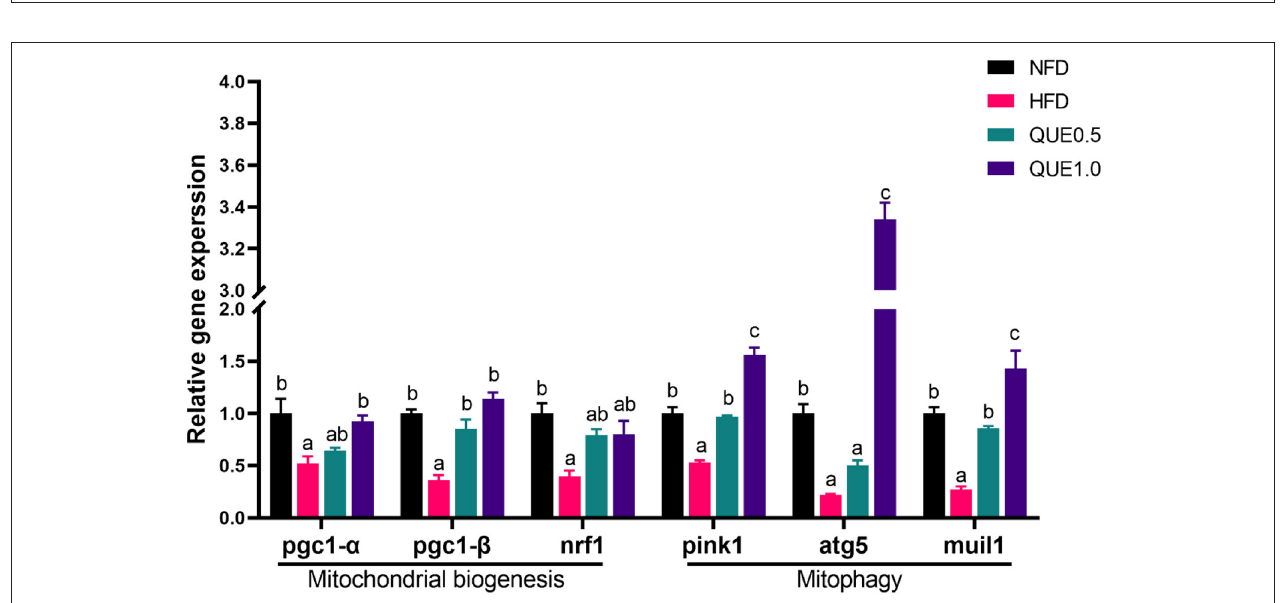
FIGURE 6 | The expressions of mitochondrion-related genes in the liver of fish fed with experimental diets. Different letters indicate a significant difference among groups ( P < 0.05).